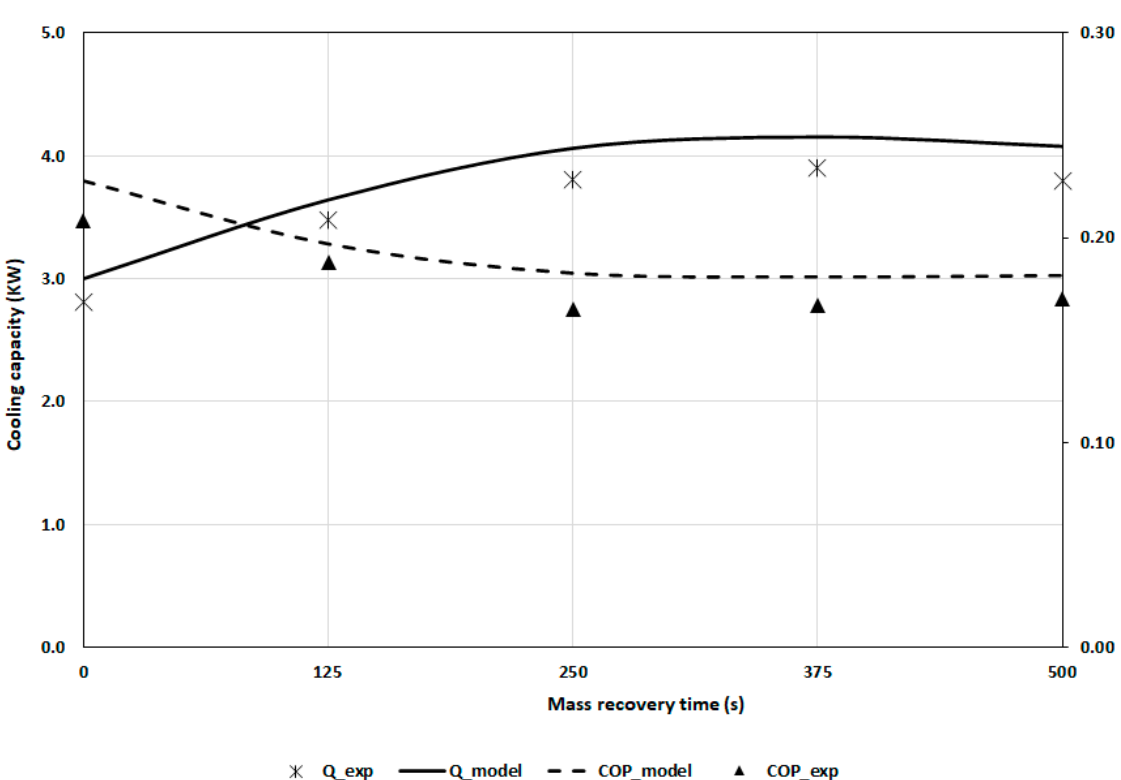
Figure 14. Comparison between experimental and predicted COP and cooling capacity with various mass recovery times at T hw_in of 90 °C, T cw_in of 50 °C, and T chw_in of 18 °C.